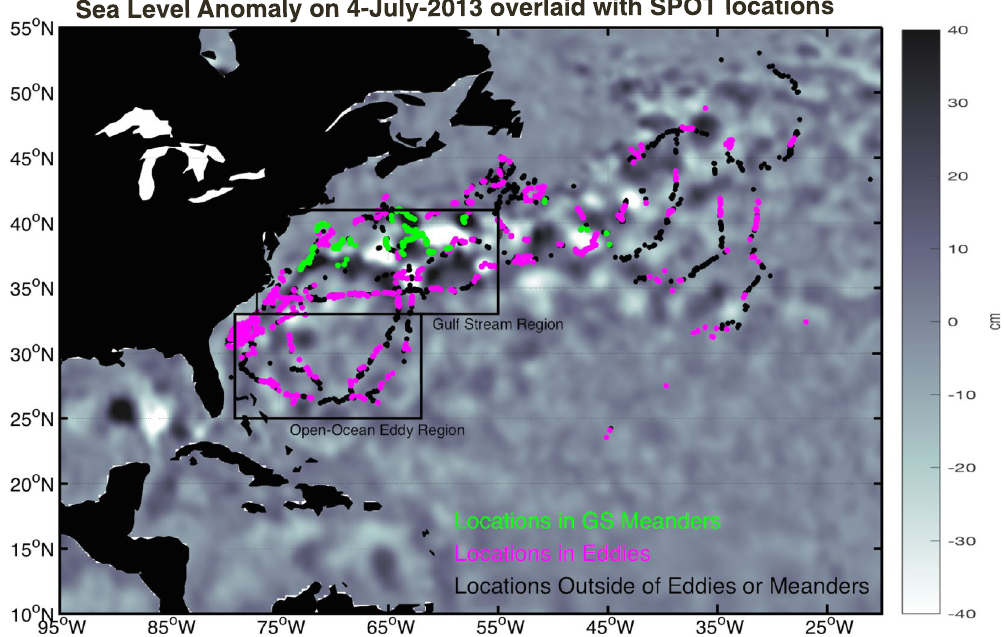
Figure 1. Map of the sea level anomaly on 4-July-2013 (shading) overlaid with SPOT tag positions of the 2 white sharks analyzed here. Positions inside eddies are shown as magenta points, in Gulf Stream meanders as green points, and outside of mesoscale features as gray points. The approximate bounds of the two study regions described in the text are indicated by the black boxes. This map was generated using the m_map toolbox (https://www.eoas.ubc.ca/~rich/map.html) implemented in Matlab